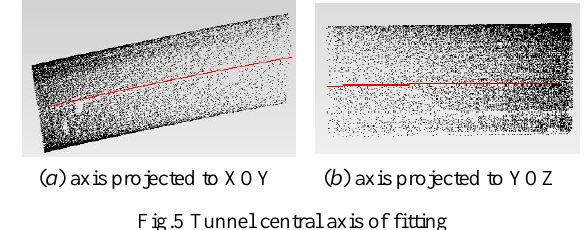
Fig.5 Tunnel central axis of fitting